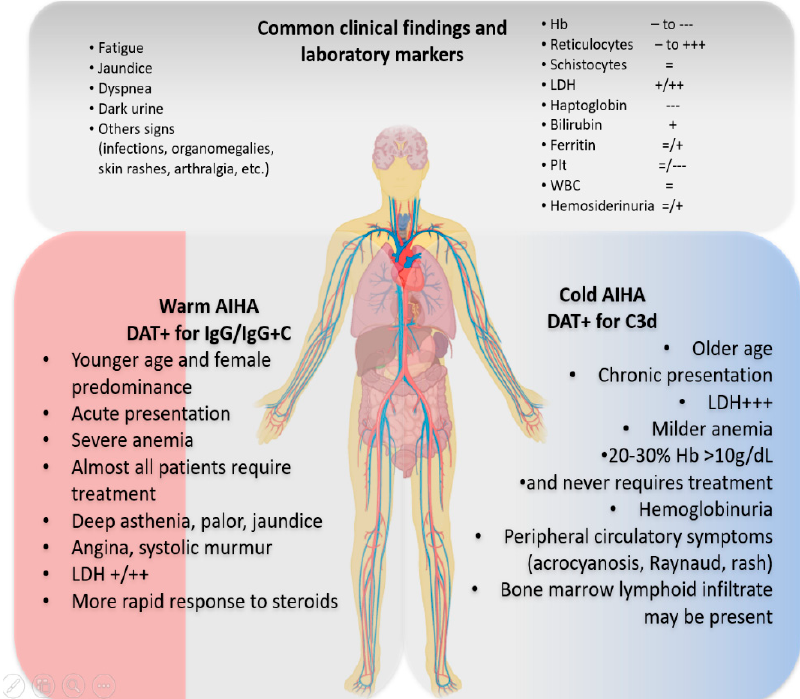
Figure 1. Clinical and laboratory findings in patients with primary autoimmune hemolytic anemia (AIHA). Symptoms and signs related to anemia and hemolysis are common to warm (wAIHA) and cold (cAIHA) forms. Hemoglobin (Hb), other blood counts (platelets Plt, white blood cells WBC), hemolytic markers (lactate dehydrogenase LDH, reticulocytes, haptoglobin, bilirubin, and hemosiderinuria), ferritin and schistocytes can be either normal =, slightly reduced -, reduced --, and very reduced --- or slightly increased +, increased ++, and very increased +++. In wAIHA, direct antiglobulin test (DAT) is usually positive for IgG with or without complement; cAIHA are DAT positive of complement fraction C3d. Some clinical and laboratory features are different and help to reach the diagnosis.